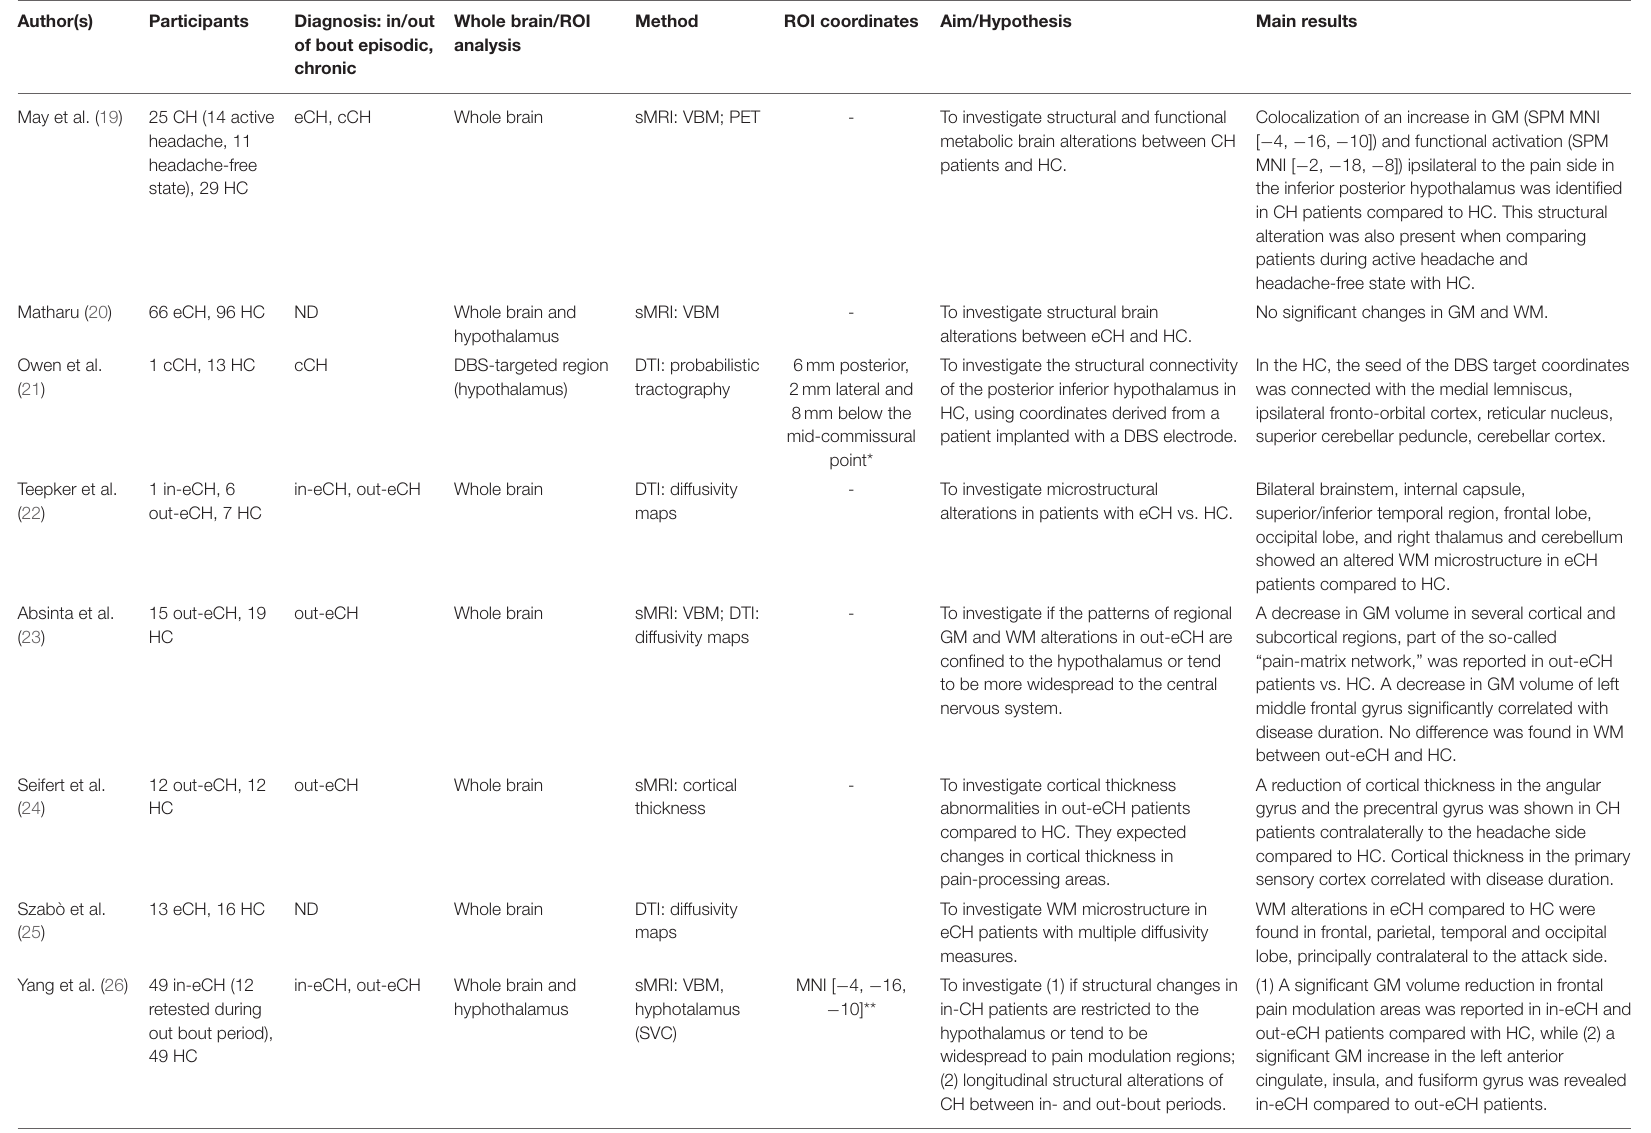
TABLE 2 | List of structural studies on cluster